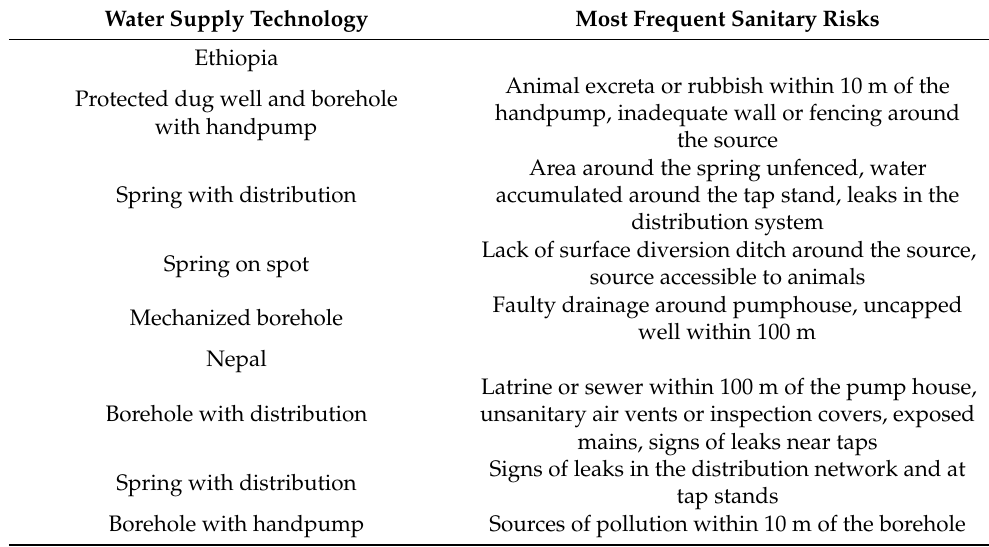
Table 6. Most frequently reported sanitary risks in Ethiopia and Nepal, by type of water supply